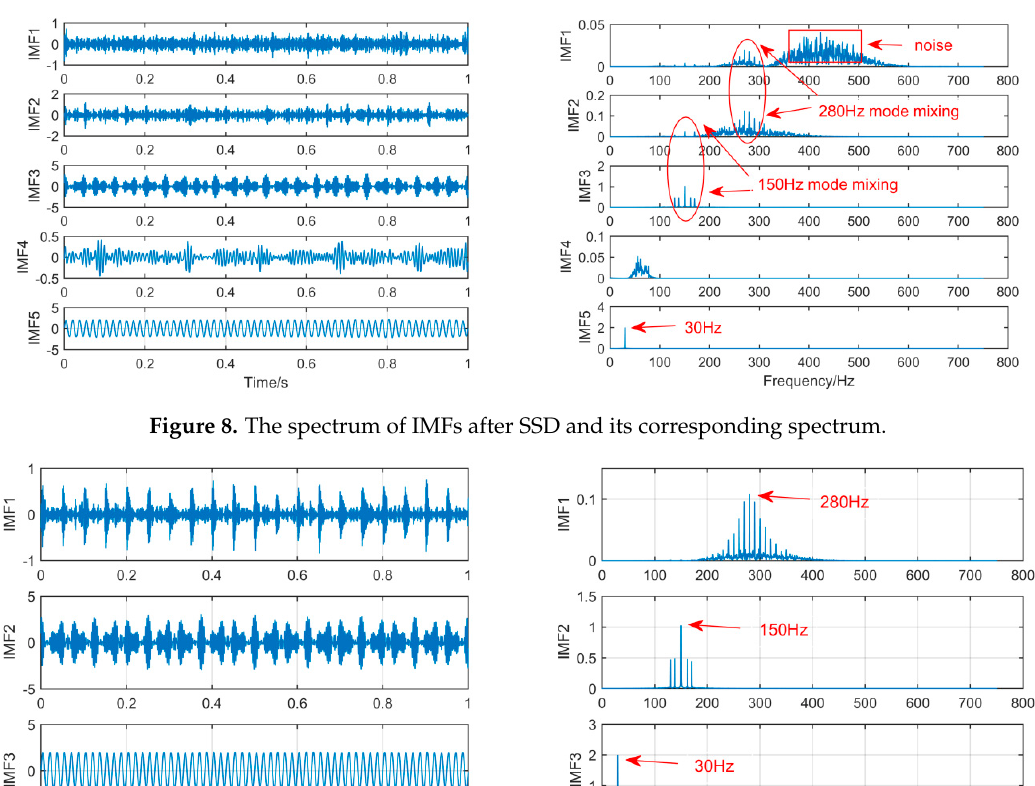
Figure 9. The spectrum of IMFs after MSSD and its corresponding spectrum.